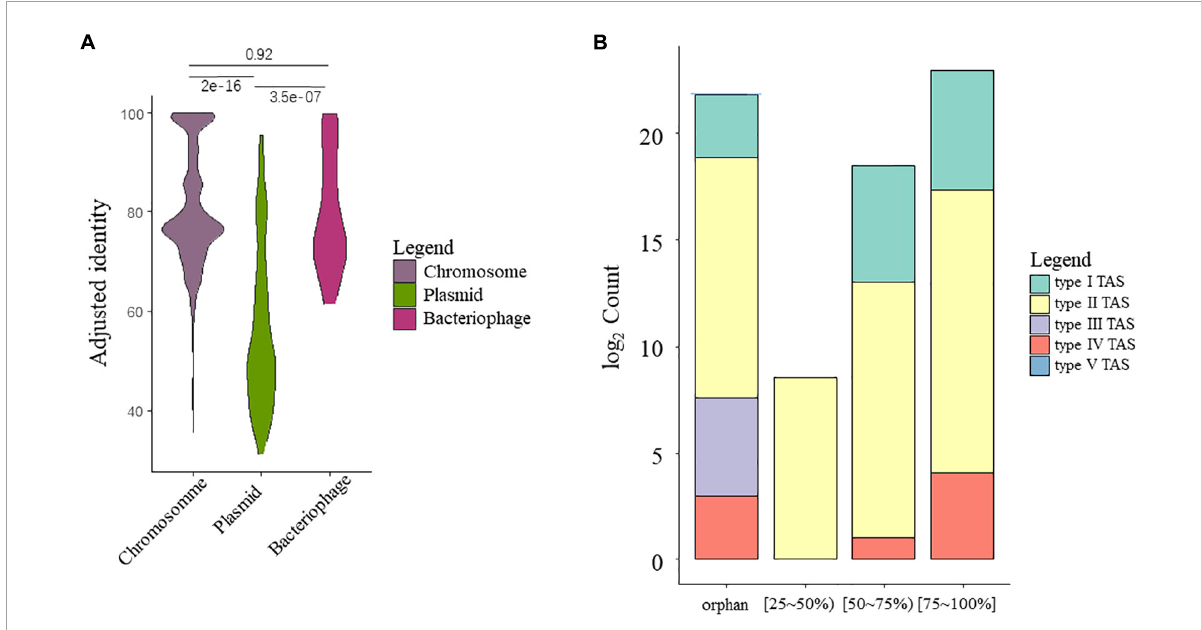
FIGURE2 Overview of the putative TA gene hits. (A) Identity preference of putative TA gene hits toward different categories. Pairwise significance tests were conducted using Kruskal–Wallis test. (B) Counts of TA gene hits grouped by mean AIMH scores and TA